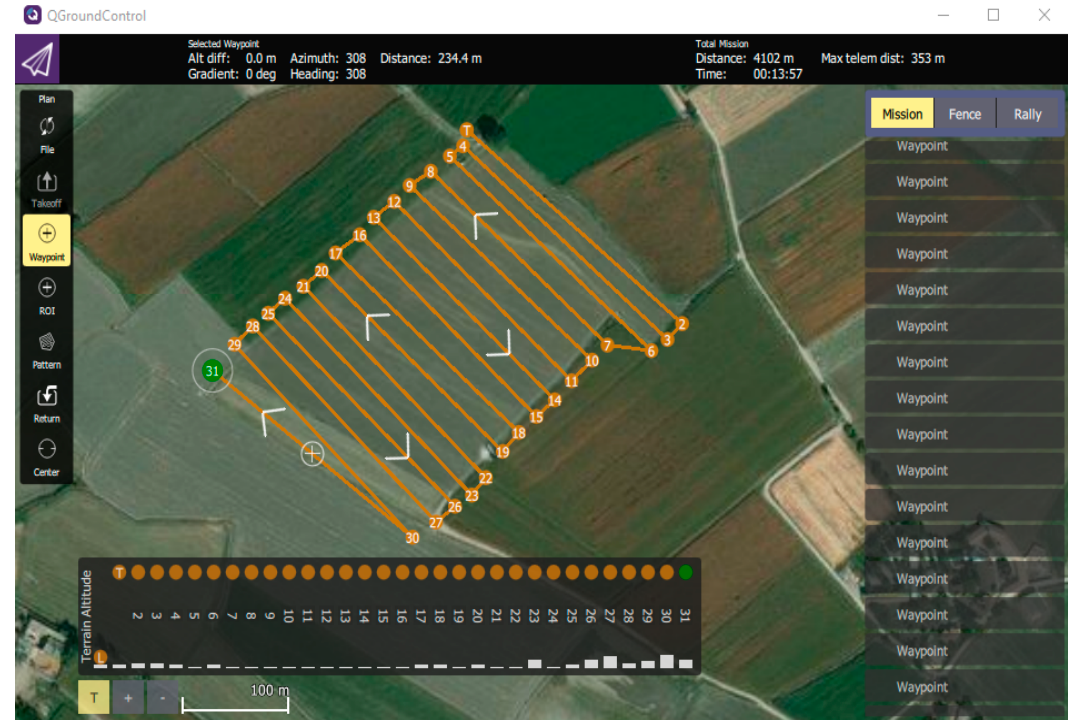
Figure 3. QGroundControl (an open source software) interface is represented, where the current window shows a setting of waypoints for flight planning.